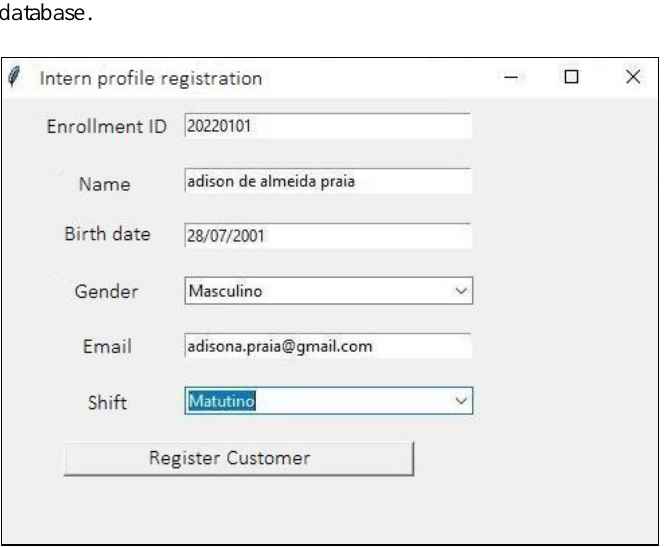
Figure 26: Registering the trainee